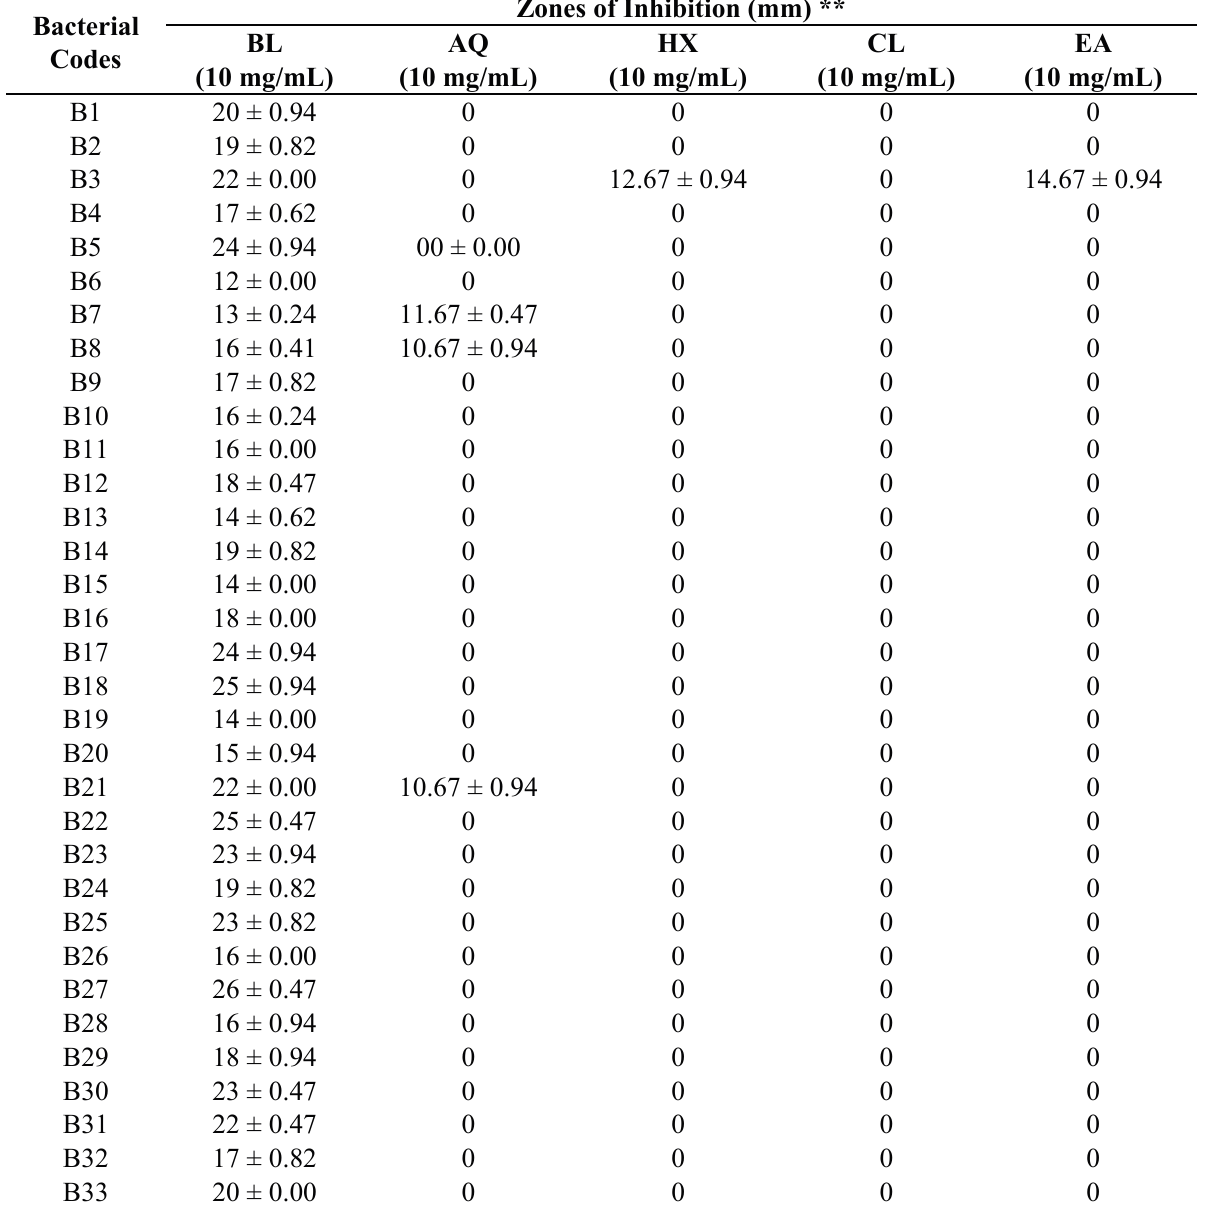
Table 1. Sensitivity patterns of zones of inhibition exhibited by the fraction obtained from the Persea americana extract on bacterial